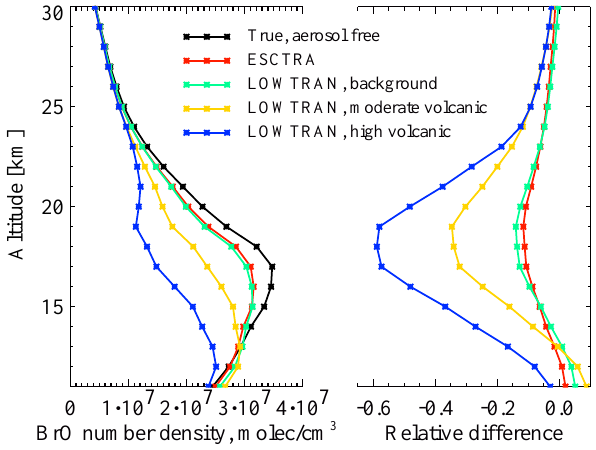
Fig. 16. Influence of the temperature dependence of the BrO ab- sorption cross section on retrieved profiles. Left panel: examples of temperature profiles for high-latitude spring (blue), mid-latitude fall (green), subtropical summer (orange), and tropical winter (red). The dashed black line shows a temperature of 223K. Right panel: relative differences between BrO profiles retrieved assuming a con- stant BrO cross section at 223K and corresponding true profiles. The results are obtained with the IUP Bremen algorithm.